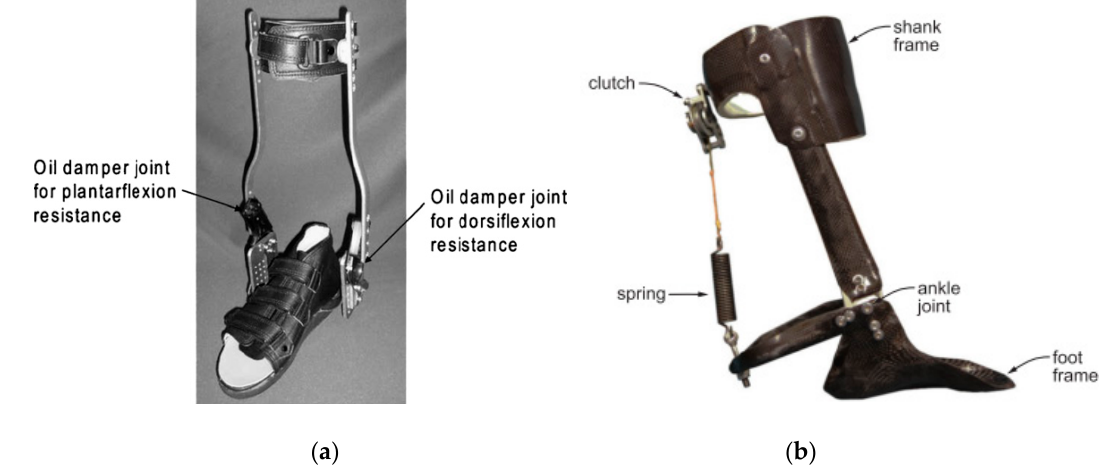
Figure 7. AFO with damping stiffness control. ( a ) Oil damper [67]; ( b ) spring [20].